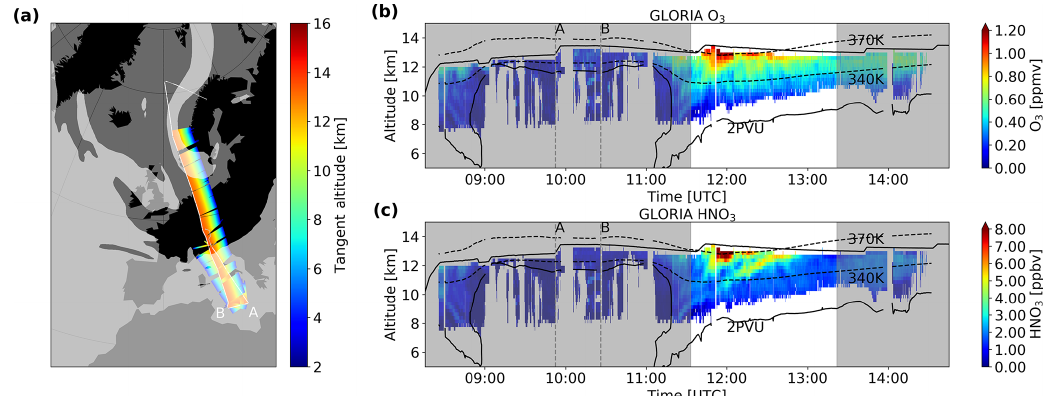
Figure A2. (a) Flight path and vortex filtering according to the Nash criterion at 370K for flight 6 on 12 January 2016. White line: flight track with characteristic waypoint (A, B); dark grey shading: areas that are associated with the polar vortex. Cross sections of (b) O 3 and (c) HNO 3 distribution derived from GLORIA. Flight altitude (bold black line), characteristic waypoints (A, B), 340 and 370K potential temperature levels (MERRA-2, dashed black lines), and 2PVU level (MERRA-2, black line). Passages attributed to non-sub-vortex air are shaded in